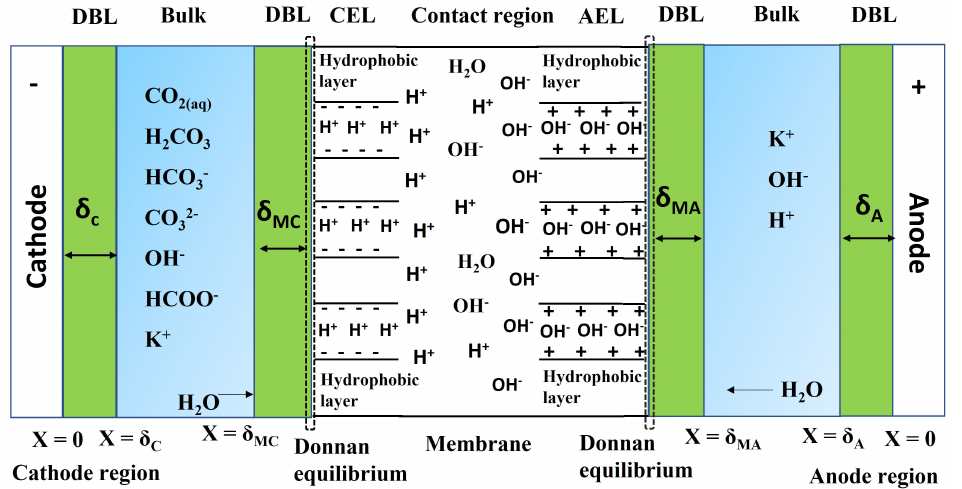
Figure 1. Schematic representation of the simulated electrochemical cell. The boxes in the figure do not represent the actual dimensions. The figure consists of a cathode, anode and the bipolar membrane regions. To explain the water dissociation reactions at the interphase, the box containing the membrane region is shown larger than the other regions. The dotted line indicates the Donnan equilibrium at the membrane–electrolyte interphase. The following abbreviations are used in the figure: DBL is the diffusion layer, CEL is cation exchange layer, AEL is anion exchange layer, δ is the diffusion layer thickness, δ C and δ A represent the diffusion layer at the cathode and anode, respectively. δ MC and δ MA represent the diffusion boundary layer at the cathode and anode side membranes,